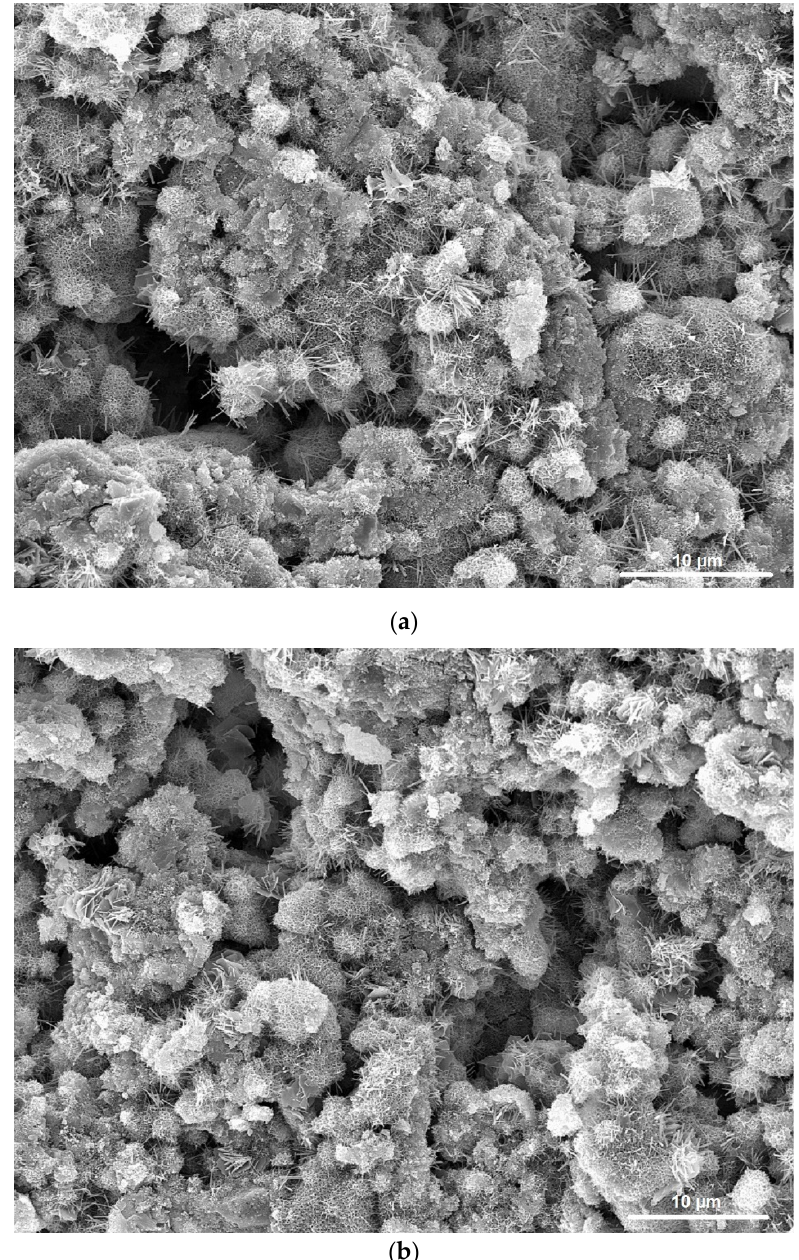
Figure 4. ( a ). Sample microstructure of “conventional” cement slurry (with no addition of n -SiO 2 ). Magnification 1000×. ( b ). Sample microstructure of “conventional” cement slurry (with no addition of n -SiO 2 ). Magnification 1000×.